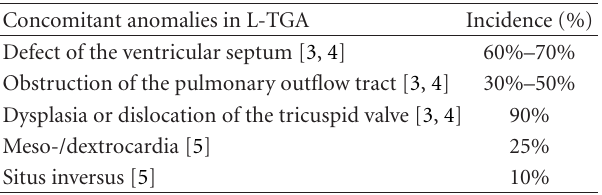
Table 1: Concomitant anomalies in L-TGA are